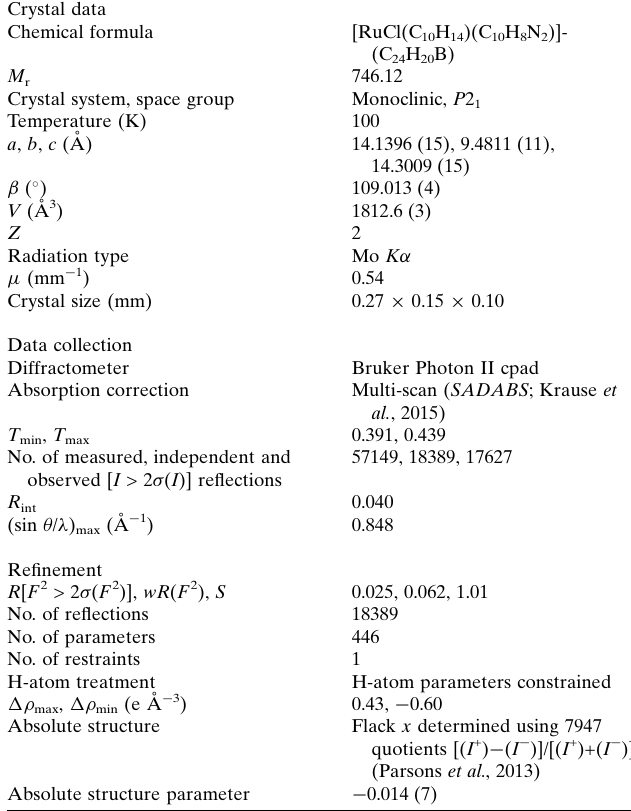
Table 3 Experimental details. Crystal data Chemical